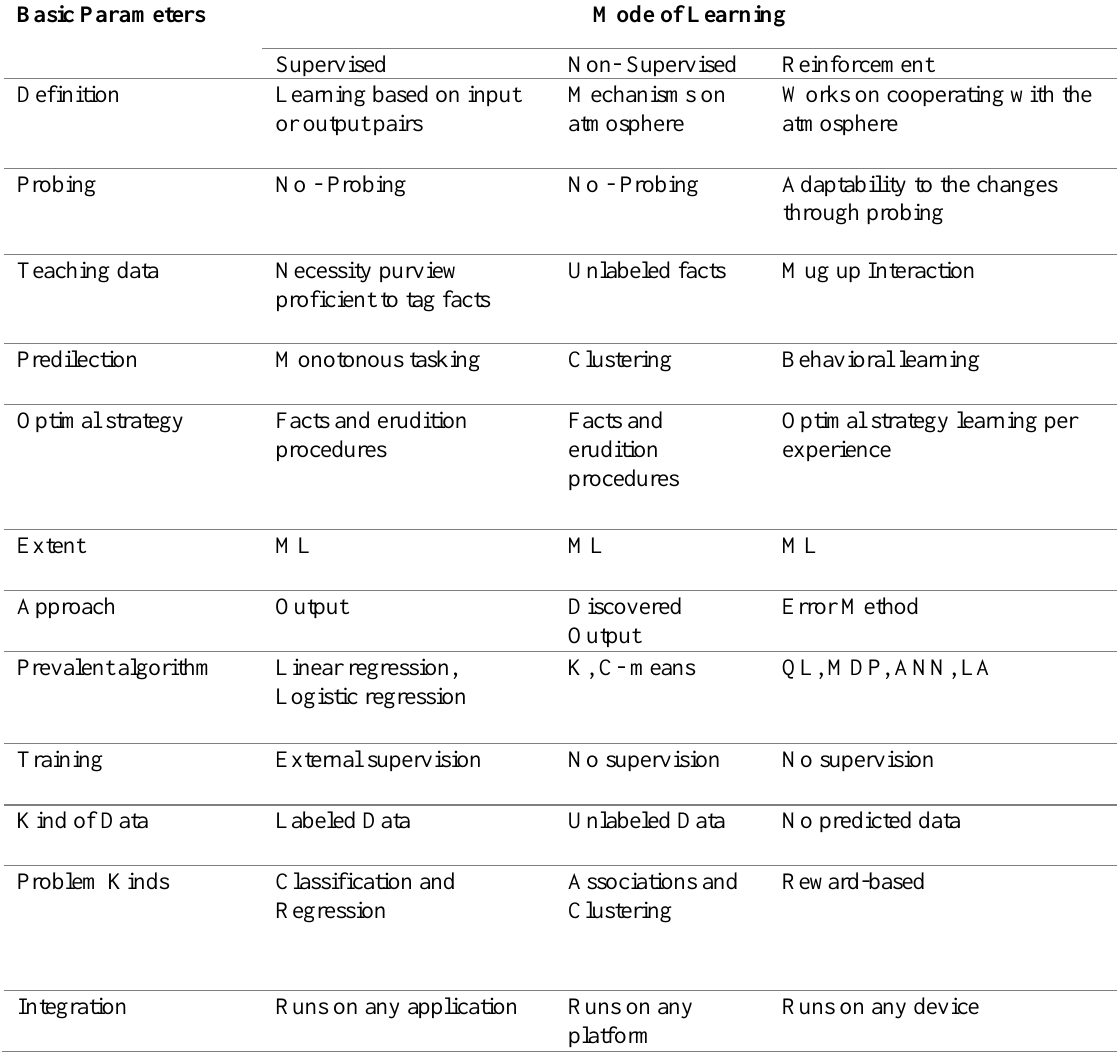
Table 1. Distinct differences between machine learning